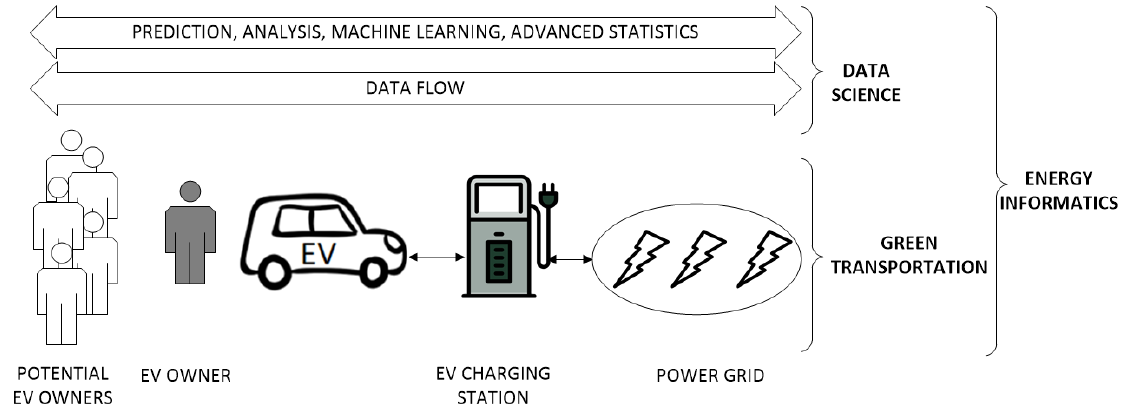
Figure 2. Interaction between entities in research area of